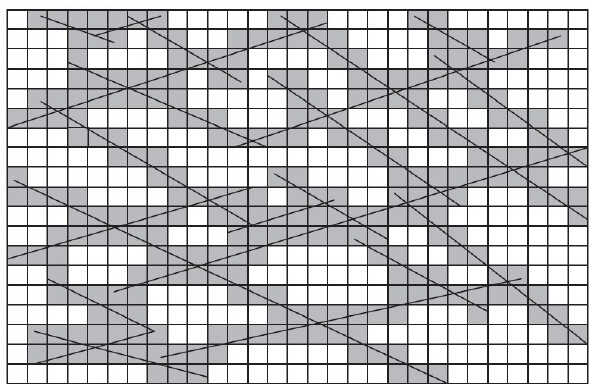
Figure 4. Illustration of finite difference representation of a hypo- thetical rock fracture network (modified from Reeves et al.,